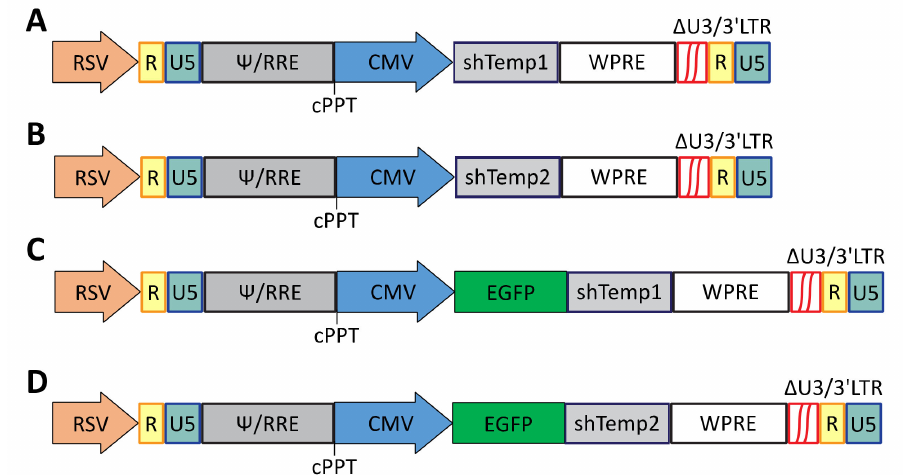
Figure 1. Schematic representation of the cPPT.hCMV.GFP-based lentiviral vectors for silencing of PKA R2A expression. ( A ) cPPT.hCMV.shTemp1; ( B ) cPPT.hCMV.shTemp2; ( C ) cPPT.hCMV.EGFP.shTemp1; ( D )